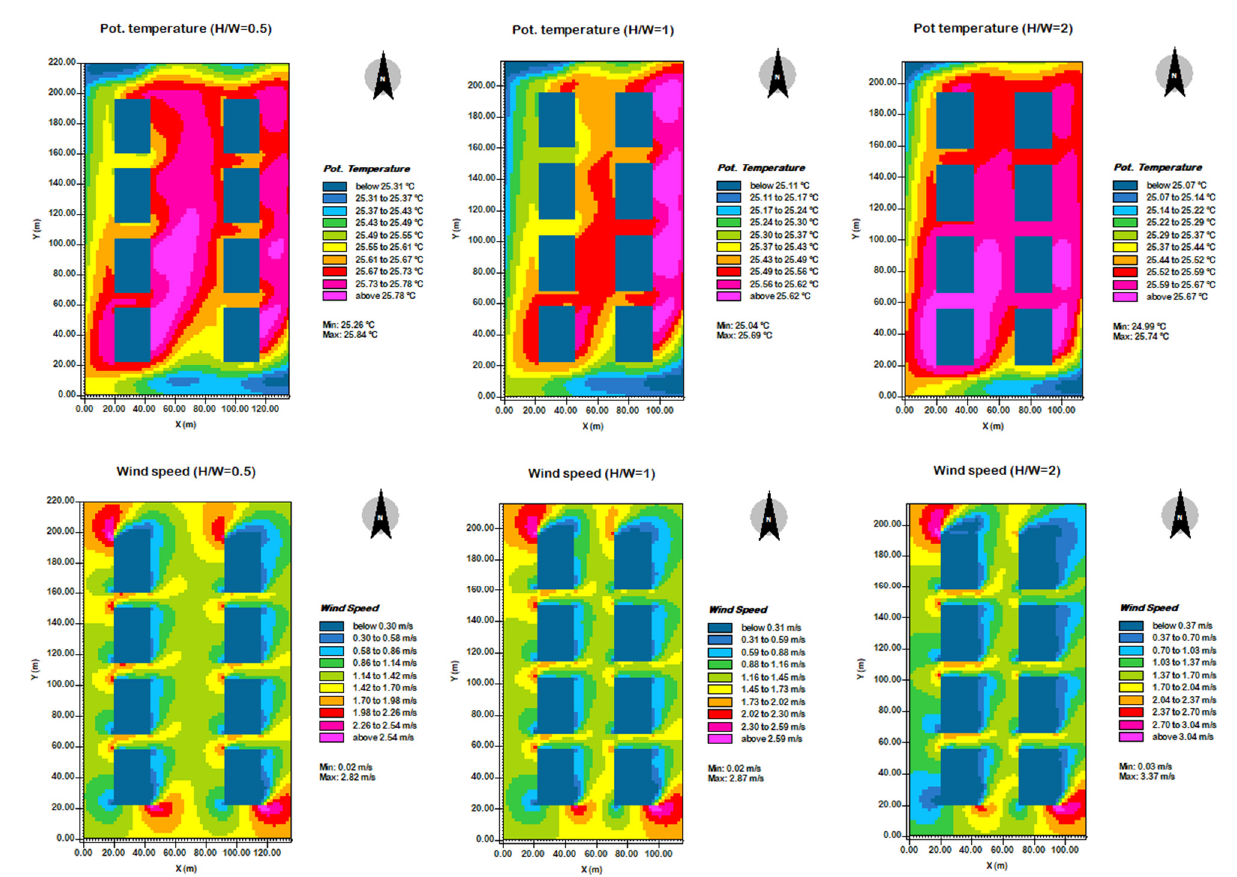
Figure 6. Air temperature and wind speed at 1.5 m height in street canyons with AR = 0.5, 1, and 2